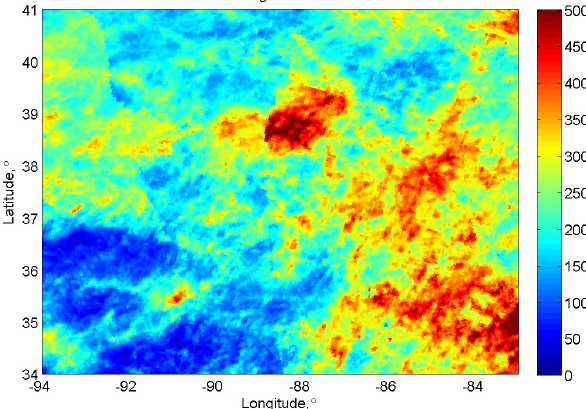
Figure 4. Observed precipitation from the NOAA Stage IV product Figure 4: Observed precipitation from the NOAA Stage IV product for 28 May – 15 July 2013 547 for 28 May–15 July 2013 (mm). Edges of the domain are excluded for clarity. (mm). Edges of the domain are excluded for clarity. 548